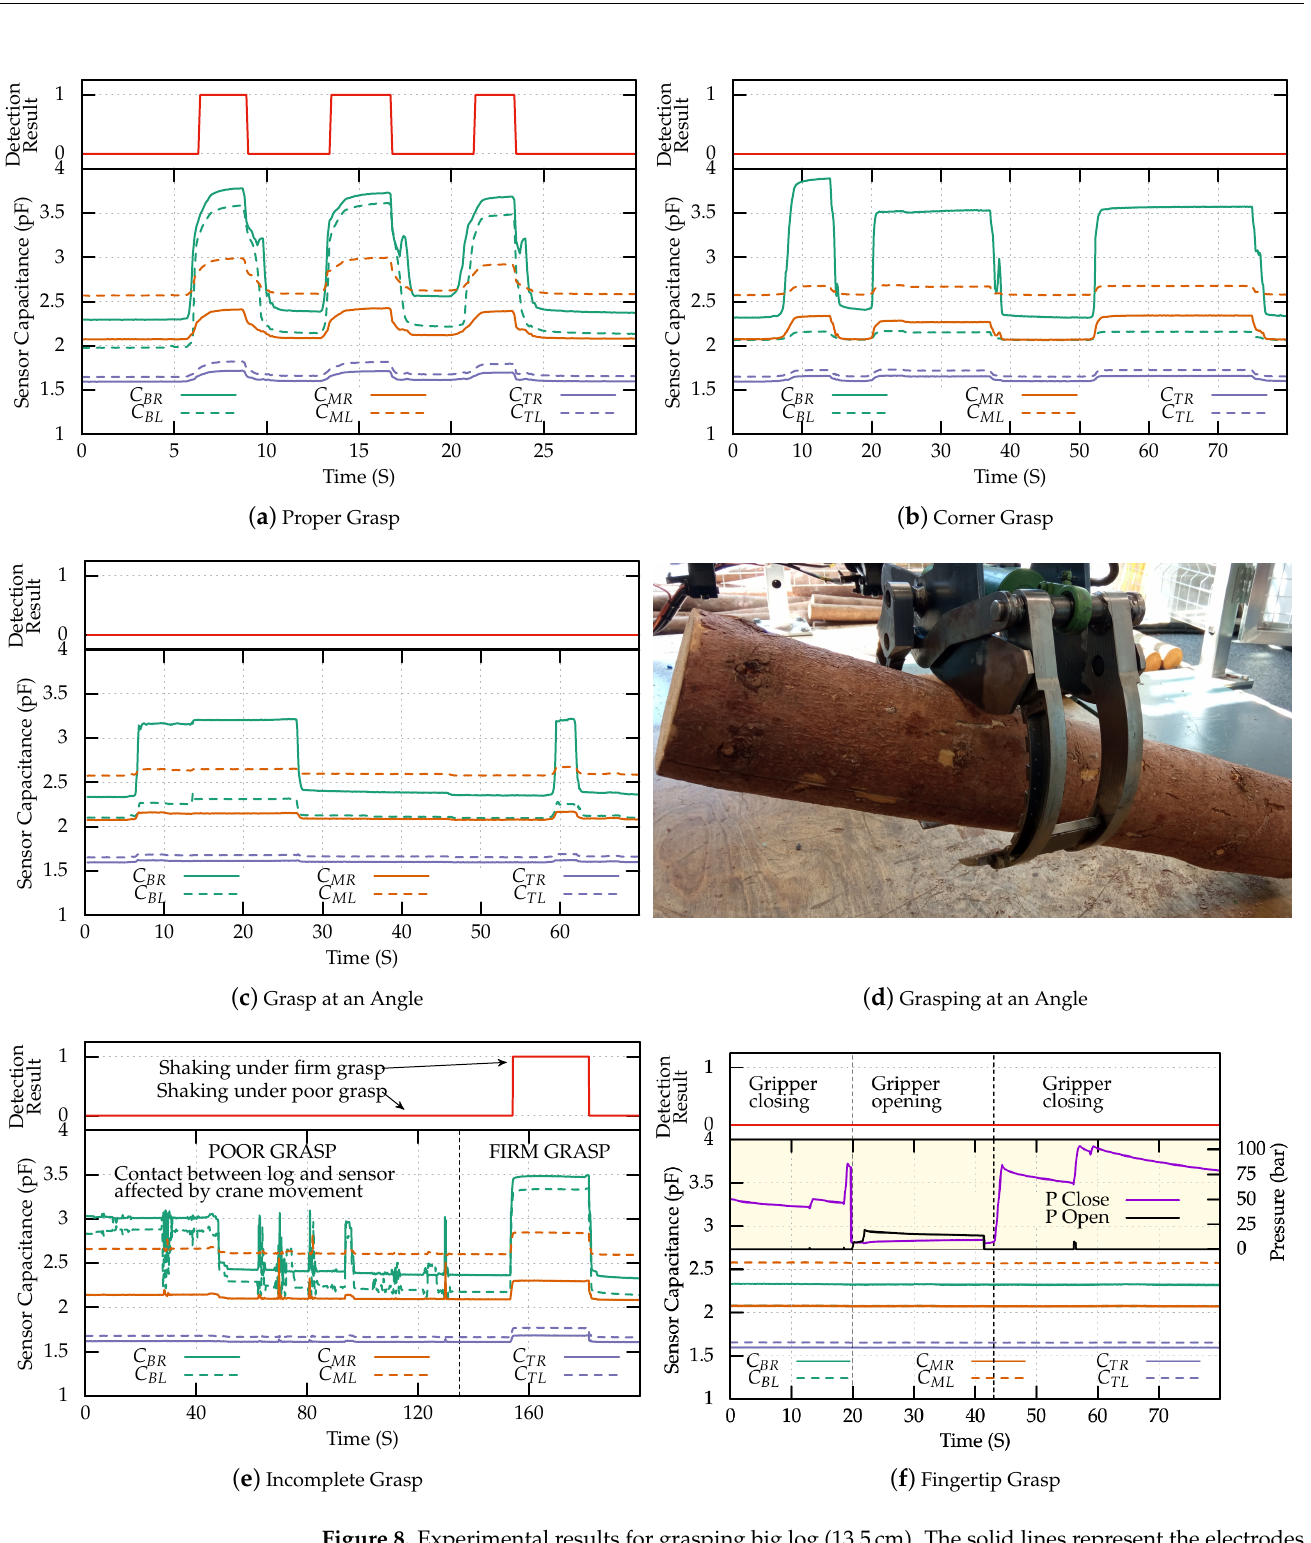
Figure 8. Experimental results for grasping big log (13.5cm). The solid lines represent the electrodes on the right claw and dashed lines represent the electrodes on the left claw. The result of detection algorithm is plotted in red on top of each plot. ( a ) shows the output of the sensors during a proper firm grasp, ( b ) shows the output of the sensors when grasping the log in the corner, ( c ) shows the output of the sensors when grasping the log at an angle and a picture of angle grasping scenario is shown in ( d ), ( e ) shows the output of the sensors when moving the log under incomplete grasp and ( f ) shows the output of both the open and close hydraulic pressure sensors (right y-axis, yellow background); and the capacitive sensors (left y-axis) during fingertip